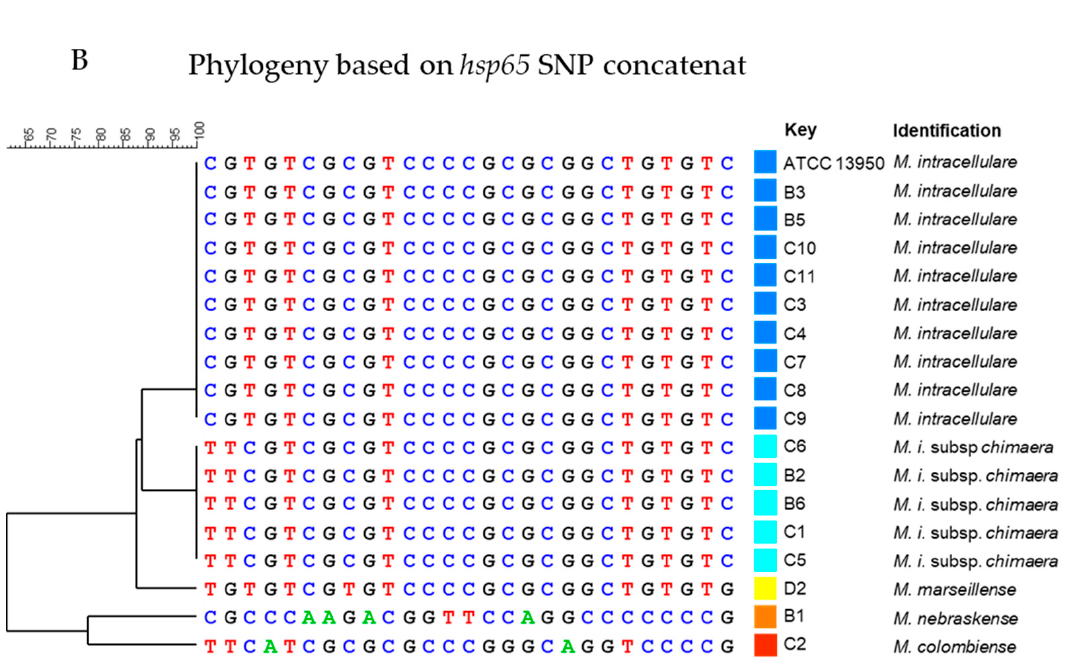
Figure 4. Identification of clinical isolates at the species level by hsp65 sequence analysis. ( A ) The hsp65 sequences are indicated in black characters in the groEL locus (blue characters). All SNPs detected in hsp65 of the 17 clinical isolates are indicated by white letters on the black background. ( B ) Alignment of the SNP concatenates detected in hsp65 associated with the mycobacterial species identified in the BIBI-QBPP database and SNP-based phylogeny carried out with the Bionumeric